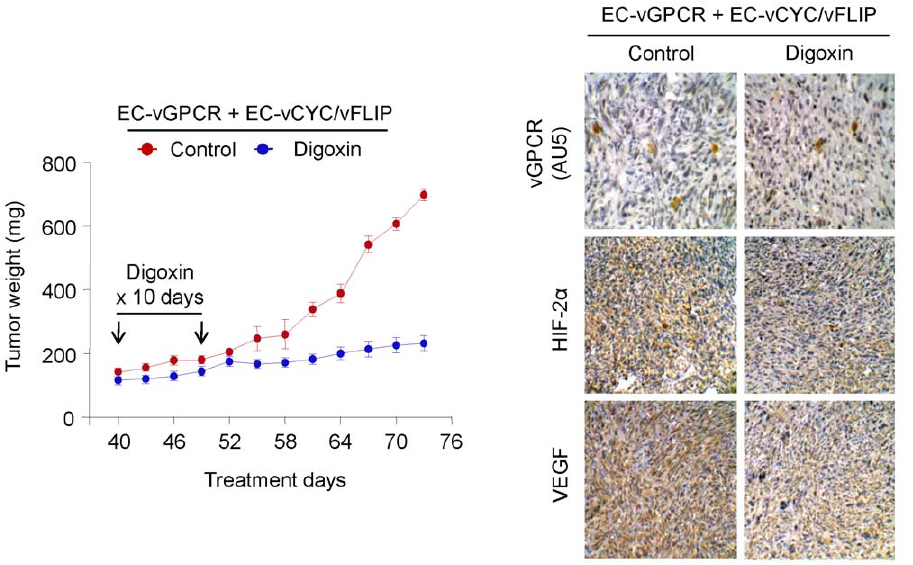
Figure 6. Inhibition of HIF blocks vGPCR tumorigenesis invivo. Tumor allografts were generated upon injection of athymic nu/nu mice with EC-vGPCR (10%) + EC-vCYC/vFLIP (90%) cells. Lesions were treated with (2 mg/kg) Digoxin or vehicle. Tumor growth curves and immunohistochemical staining of tumor tissue with anti-AU5 (revealing vGPCR-expresing cells), anti-HIF-2 a or anti-VEGF antibody, are shown.